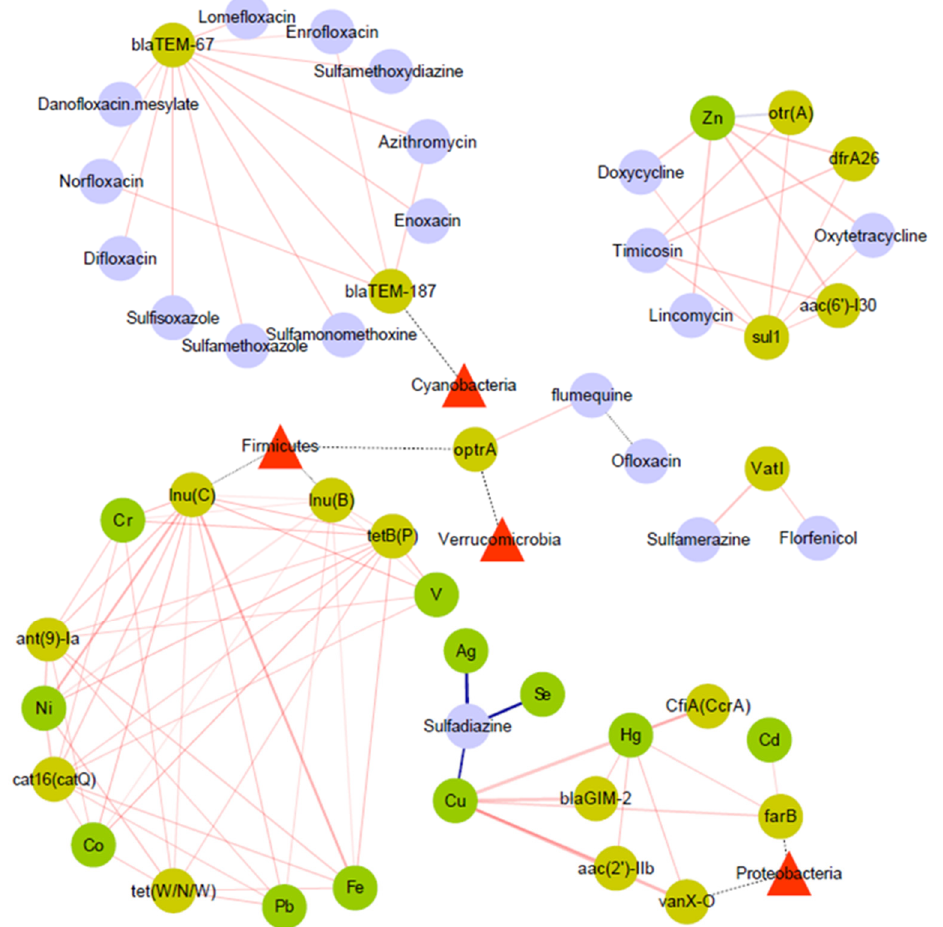
Figure 8. Network analysis of correlation. Margins are weighted according to the correlation coefficient. Red margins stand for positive correlation, blue margins stand for negative correlation, dash lines only mean the attribution of ARGs from different bacteria in phylum level. There is only significant correlation represented ( p < 0.05).